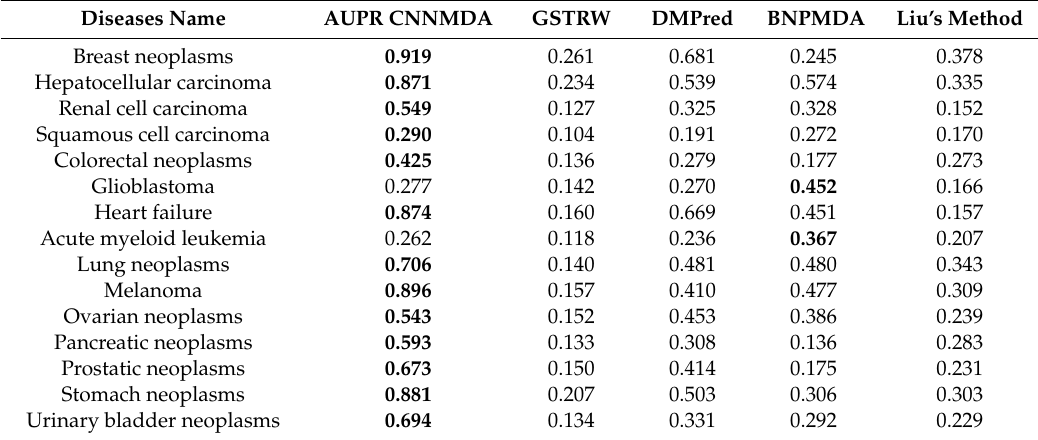
Table 2. Prediction results of CNNMDA and other four methods for 15 diseases in terms of the area under the precision–recall curve (AUPR).